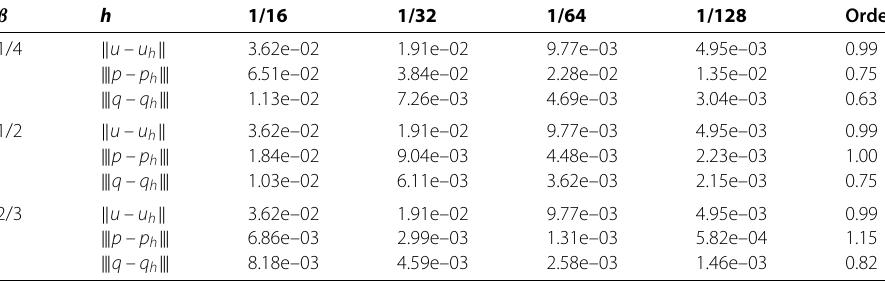
Table 3 Numerical results for Example 2 with τ = 2 –10